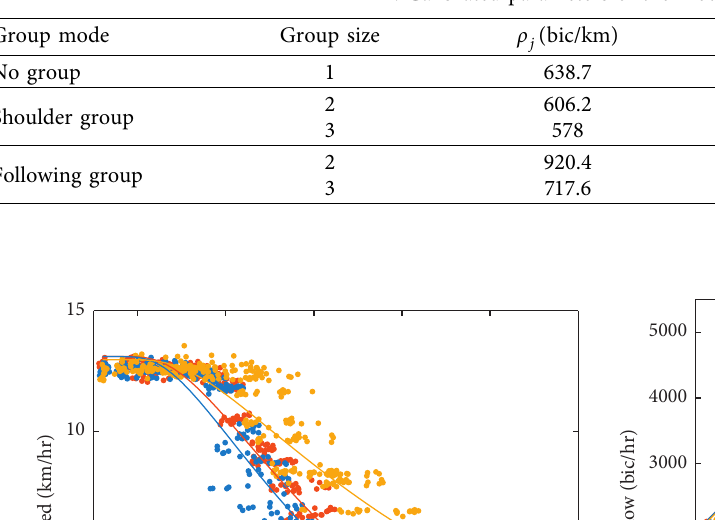
Table 2: Calibrated parameters of the modified Newell model.